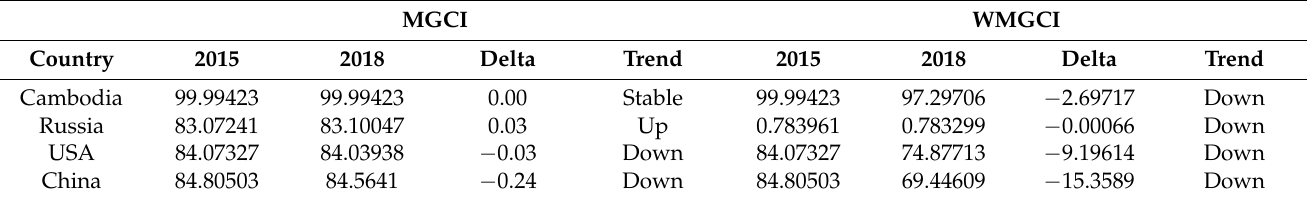
Table 7. MGCI and WMGCI calculated for 2015 and 2018 and trend analysis for Cambodia, Russia, USA, and China. MGCI WMGCI Country